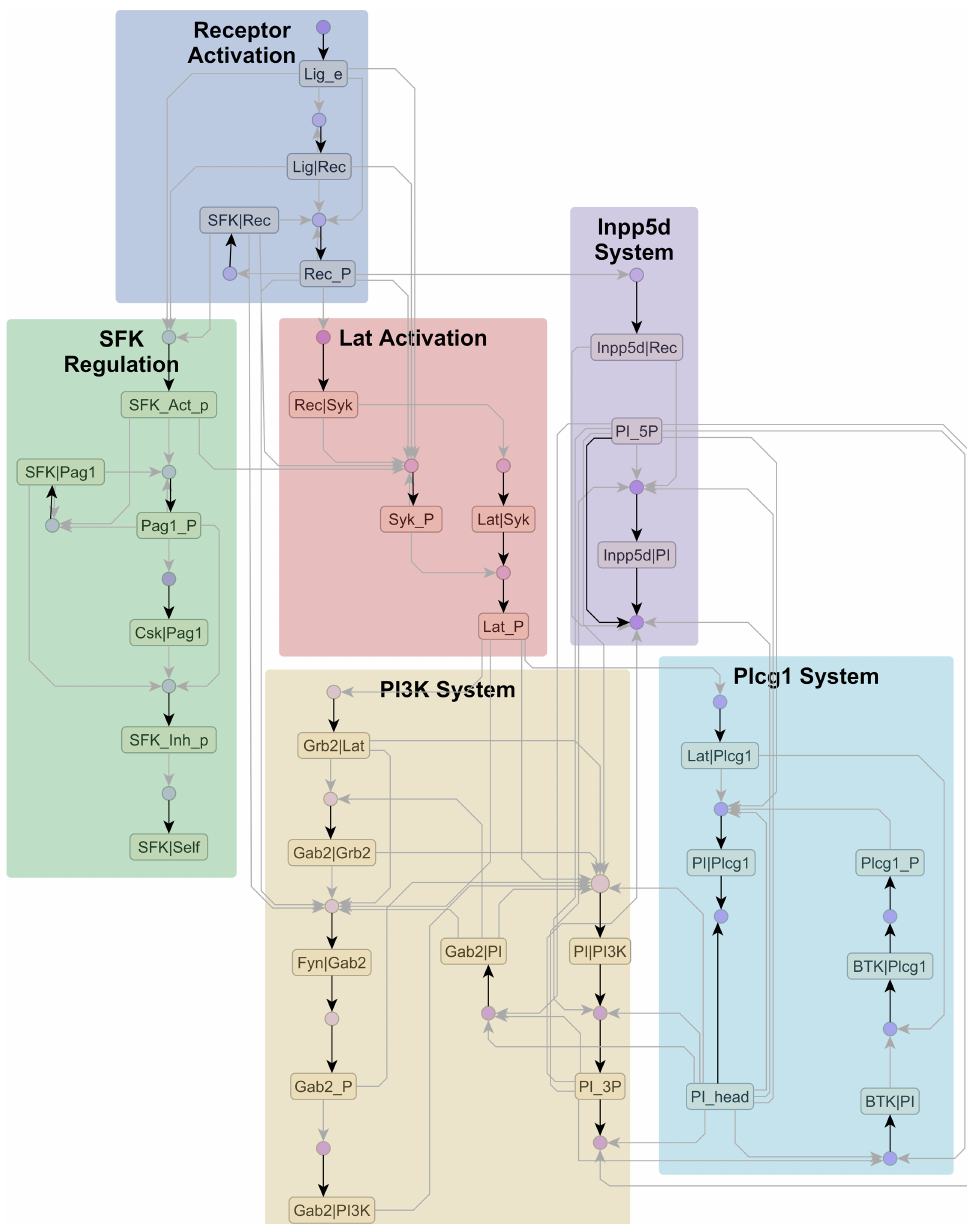
Fig 7. Fc ε RI library of rules. Compressed AR graph (63 nodes, 112 edges) generatedfrom the Fc ε RI model of Chyleket al. [10] with 178 rules. The uncompressed graph has 305 nodes and 1076edges. The model elements can be roughly classifiedinto six subsystemsshown above. The files neededto reproduce this diagram are provided in S1